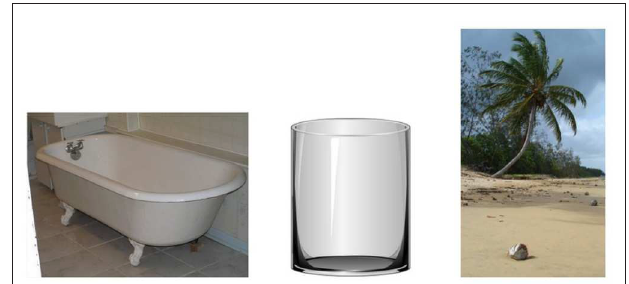
FIGURE 2 | A visual RAT item showing participants a BATHTUB , GLASS , and BEACH